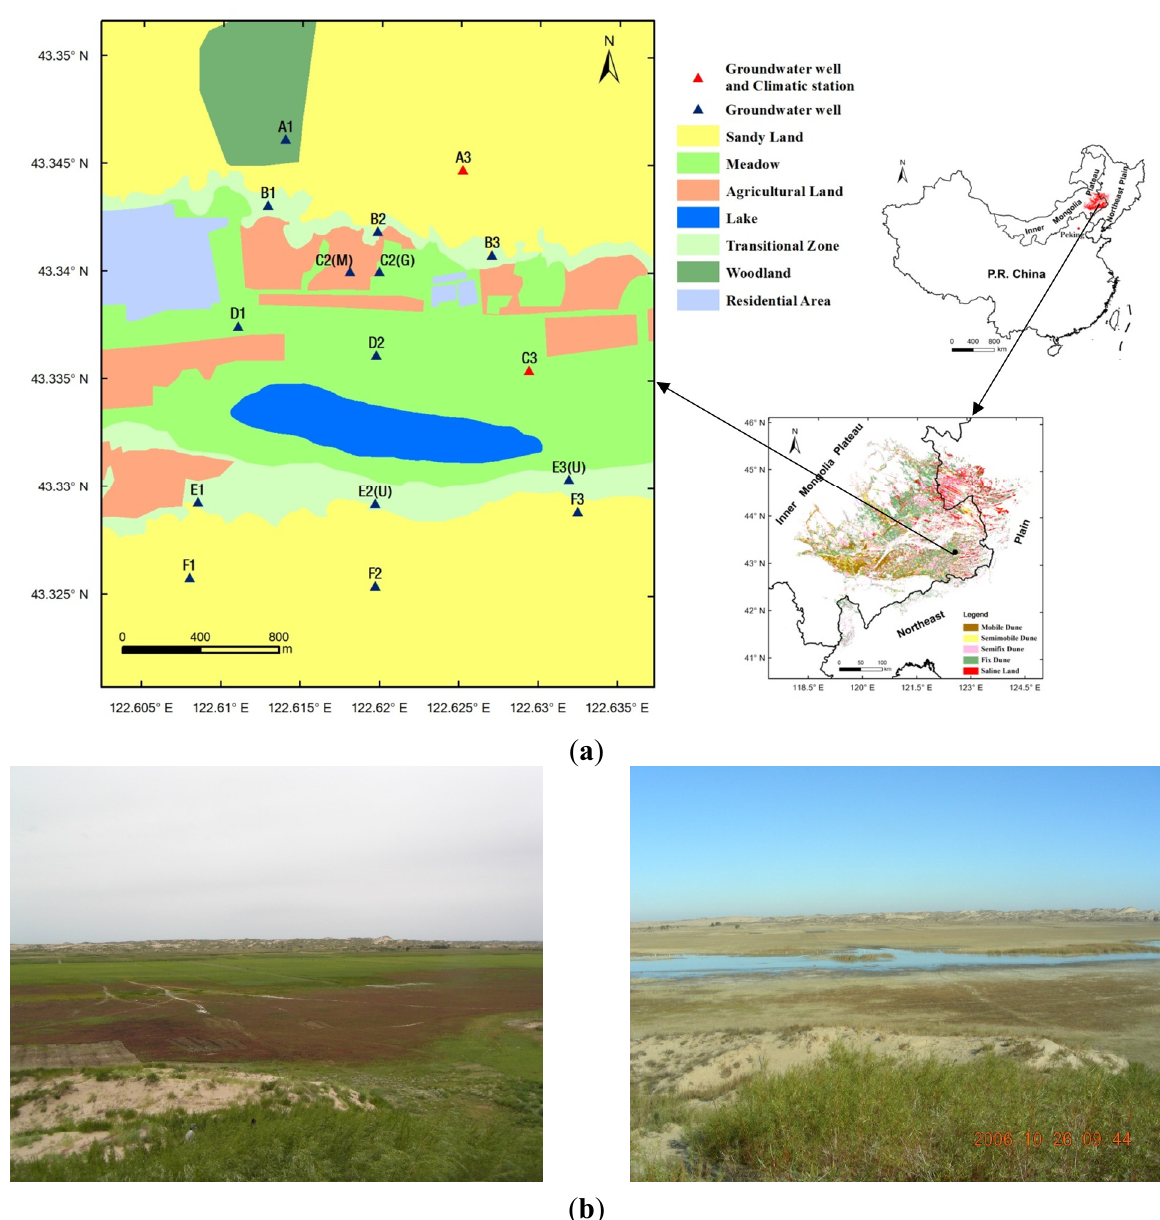
Figure 1. Map showing the: ( a ) location, landscape, and data collection points; and ( b ) topography and vegetation, of the study